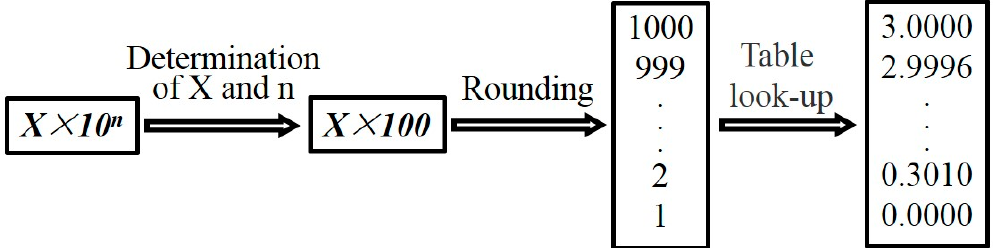
Figure 2. The calculation process of the lookup table method for logarithmic transformation based on a table of 1000 components.